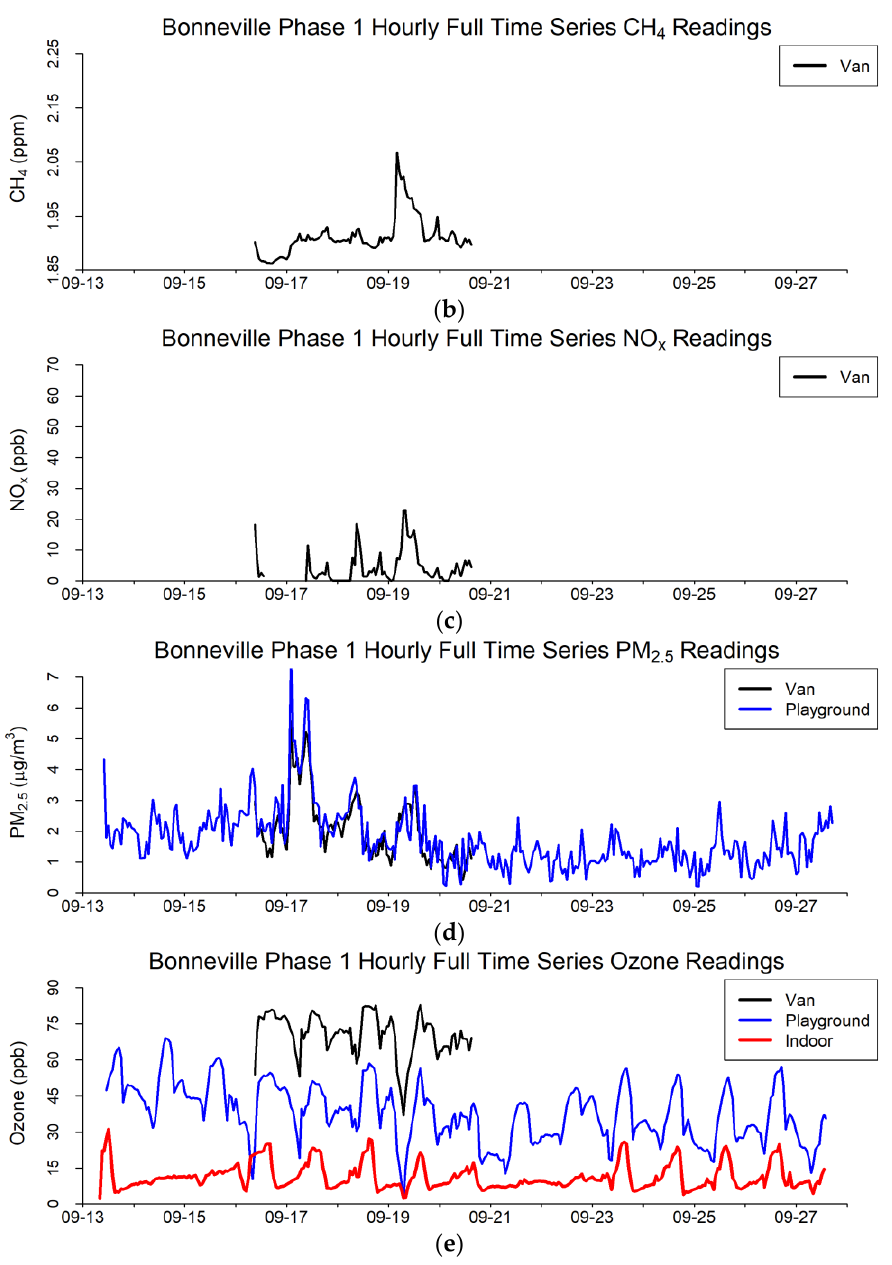
Figure 6. Time series (tick mark denotes midnight) for Bonneville Phase 1 campaign (13–27 September 2019) for ( a ) carbon dioxide, ( b ) methane, ( c ) nitrogen oxides, ( d ) fine particulate matter, and ( e ) ozone.